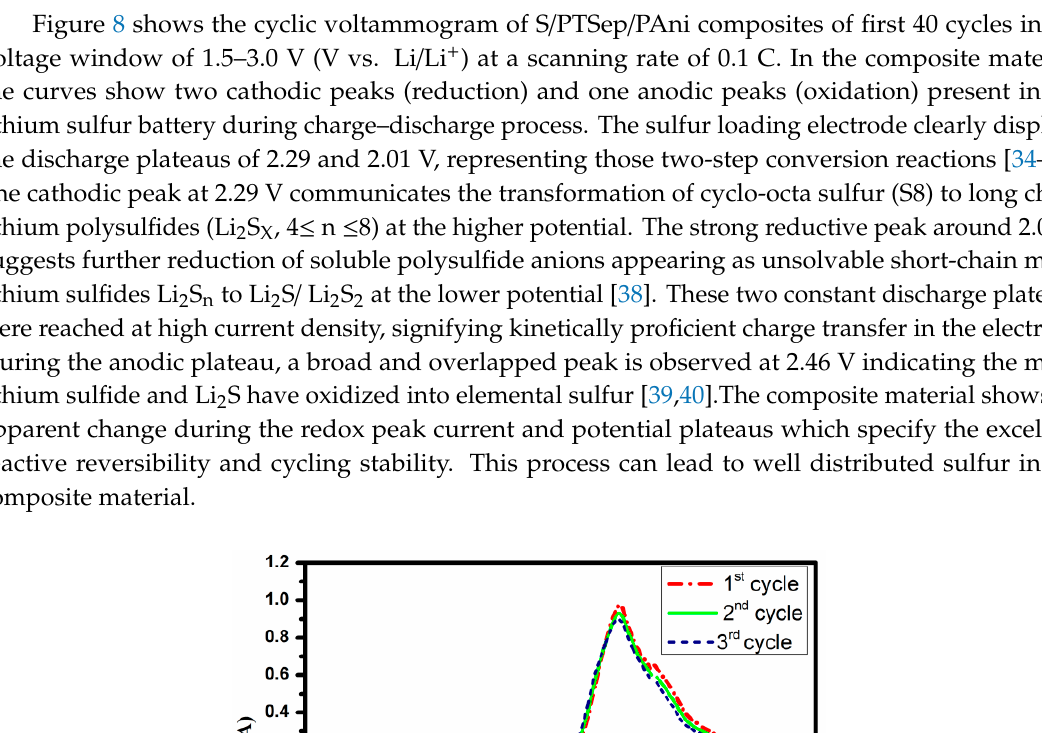
Figure 7. ( a ) Nitrogen sorption isotherms of the composite material (sublimed sulfur / post-treated Figure 7. (a) Nitrogen sorption isotherms of the composite material (sublimed sulfur /post ‐ treated sepiolite / PAni) ( b ) BJH pore size distribution of (sublimed sulfur / post-treated sepiolite / PAni). sepiolite/PAni) ( b ) BJH pore size distribution of (sublimed sulfur /post ‐ treated sepiolite/PAni).